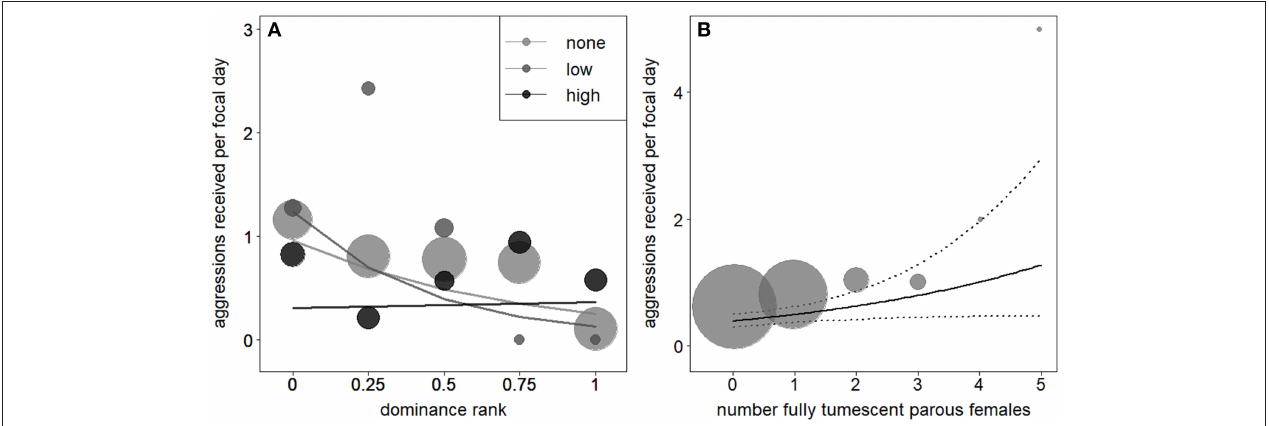
FIGURE 3 | Effect of rank instability and subject rank (1 highest rank) on number of aggressions males received (A) . The lines show the fitted model (based on group identity and group-level cooperation manually dummy coded and then centered). Effect of the number of fully tumescent parous females (B) on the number of aggressions given. The solid line indicates the fitted model (based on rank instability, group identity, and group-level cooperation manually dummy coded and then centered). The dotted lines represent the model’s 95% confidence limits. In (A,B) , larger point areas depict a larger number of